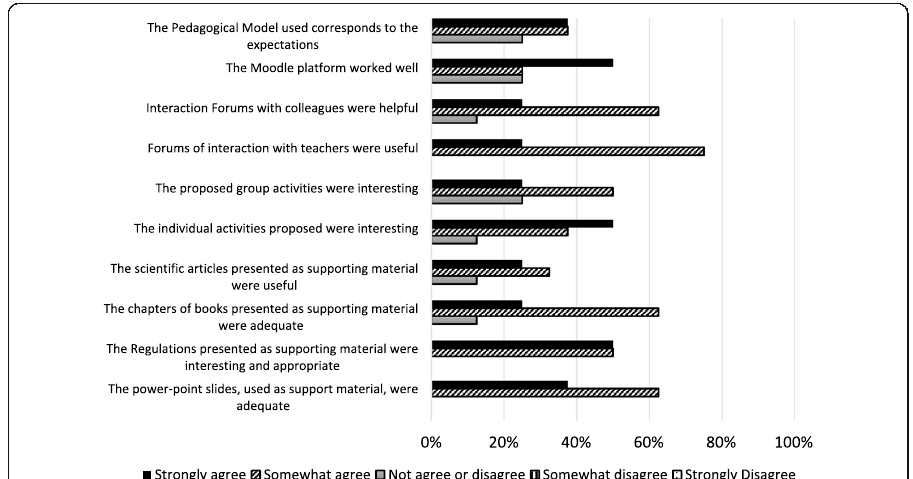
Fig. 2 Students ’ perceptions about the resources and activities of the